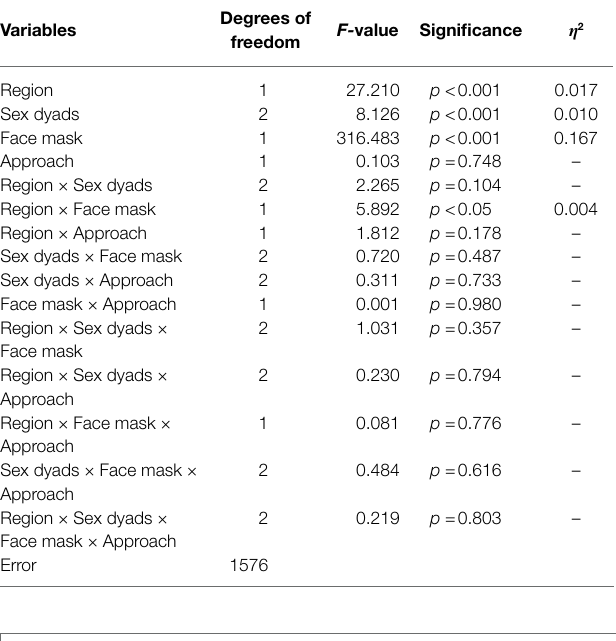
TABLE 1 | Four-way ANOVA results on interpersonal distance.